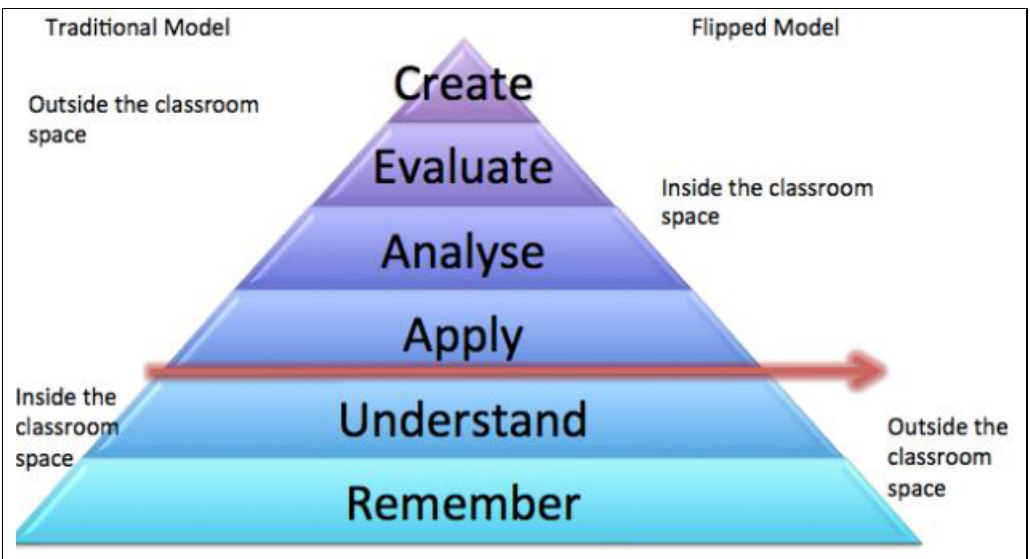
Figure 3. Bloom’s Taxonomy in the traditional classroom and the flipped classroom (Villegas,